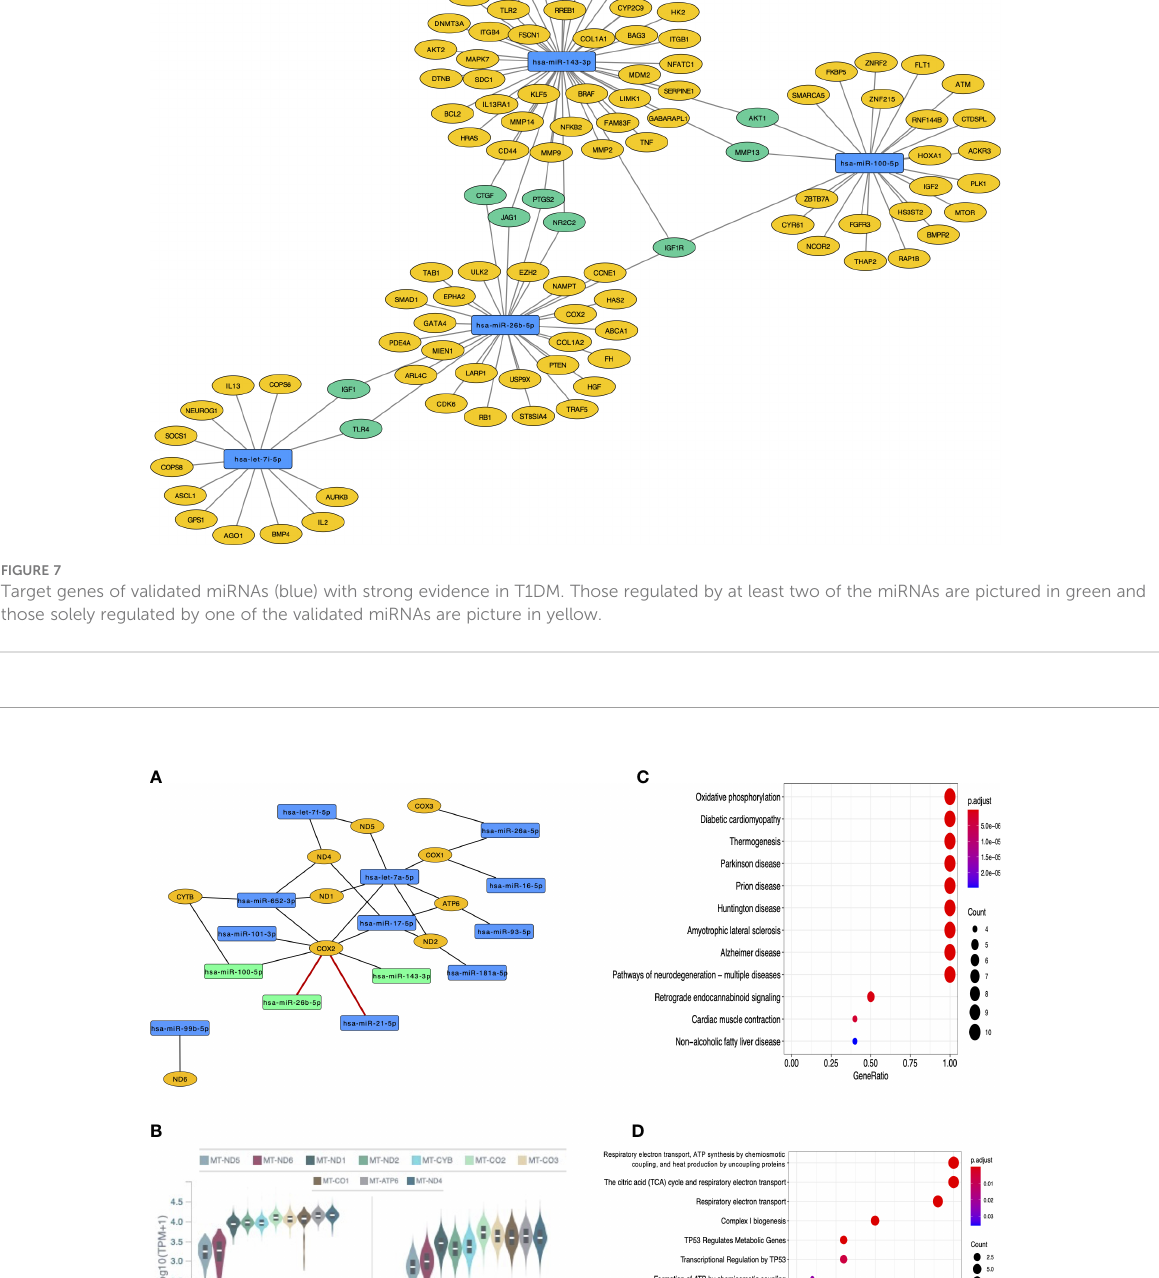
FIGURE 8 Analyses of the 14 DE miRNAs that target mitochondrially-encoded genes. (A) Network of these miRNAs (in blue or green, the latter being those validated in the current study) and the mitochondrial genes they target (in yellow); (B) GTEx data of mitochondrially-encoded gene expression in the pancreas and whole blood; (C) KEGG pathways of mitochondrial functions and some multifactorial conditions; (D) Reactome pathways of mitochondrial